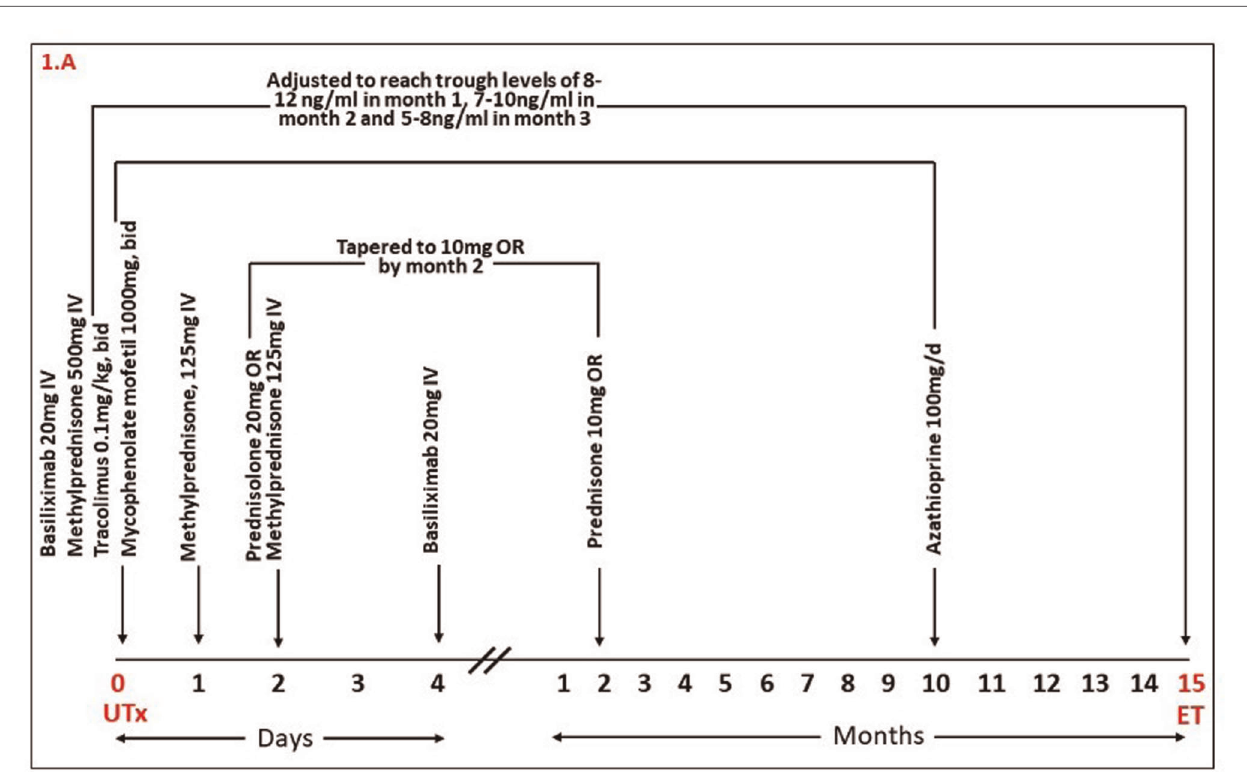
FIGURE 1 | Time-course of immunosuppression therapy during the course of patient treatment from UTx through to embryo transfer. OR, oral; UTx, Uterus Transplantation; ET, Embryo Transfer; d,